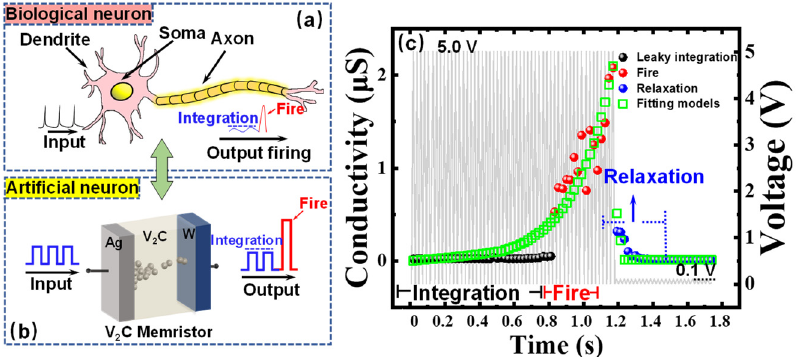
Figure 4. Experimental implementation and fitting model of a leaky integrate-and-fire (LIF) neuron realized by a single V 2 C-based memristor. ( a ) Schematic of a biological neuron receiving input from other neurons through interconnected synapses. ( b ) Diagrammatic illustration of an artificial neuron emulated by an independent V 2 C memristor. ( c ) Plot of response conductivity and fitting models (green squares) of the integration (black balls), fire (red balls), and relaxation (blue balls) function of the device under a train of input voltage pulses